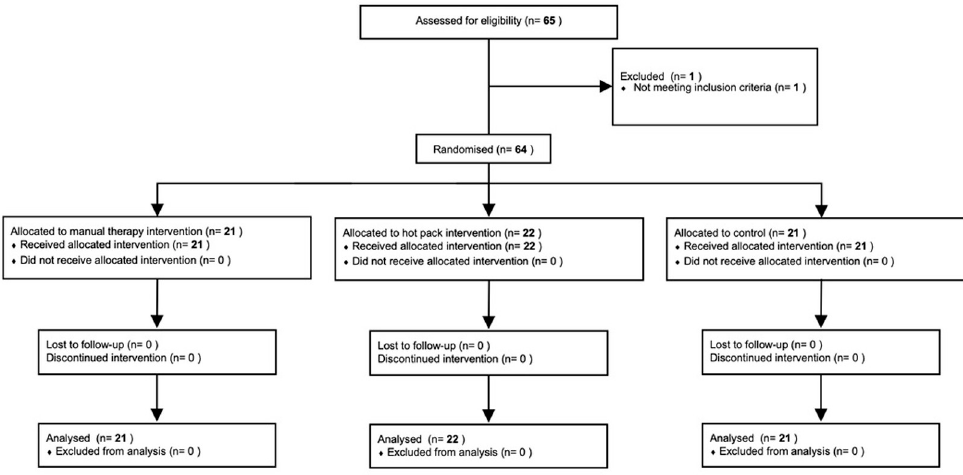
Fig 1. Participants’ progress throughout the